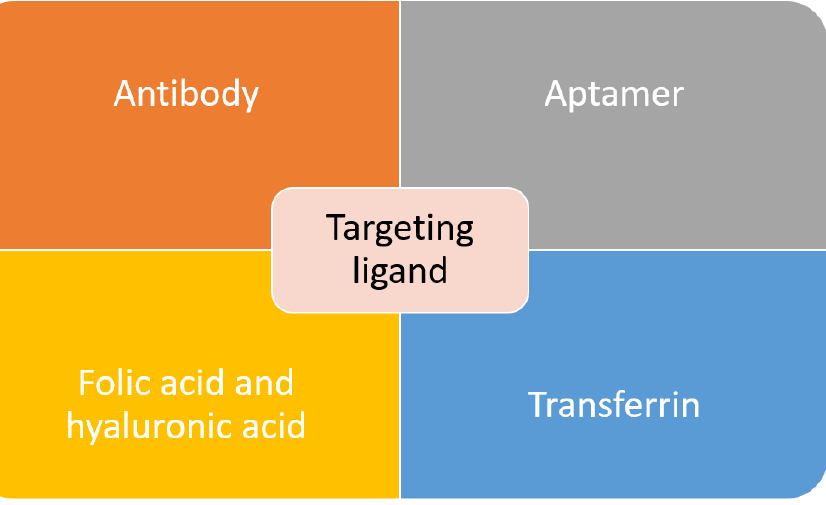
Figure 3. Common targeting ligands functionalized on MSNs.